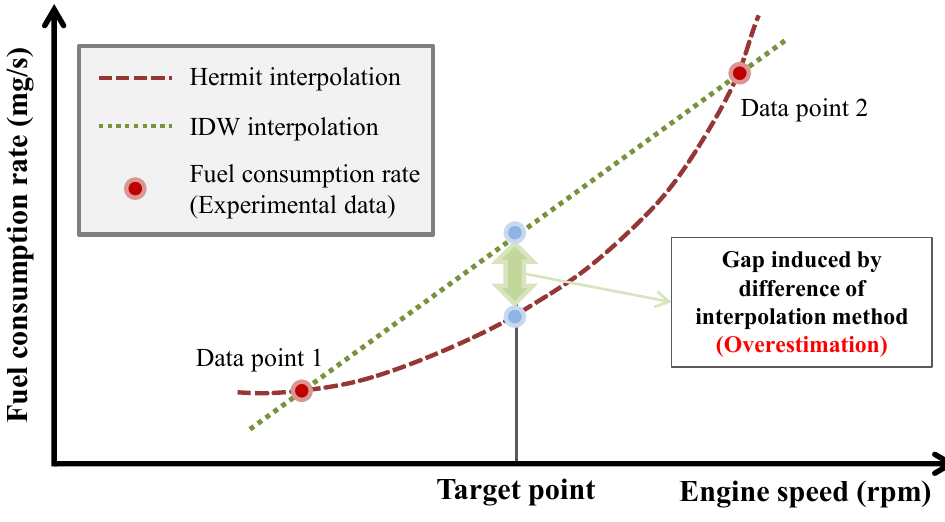
Figure 9. Difference in prediction accuracy between Hermite and IDW interpolation